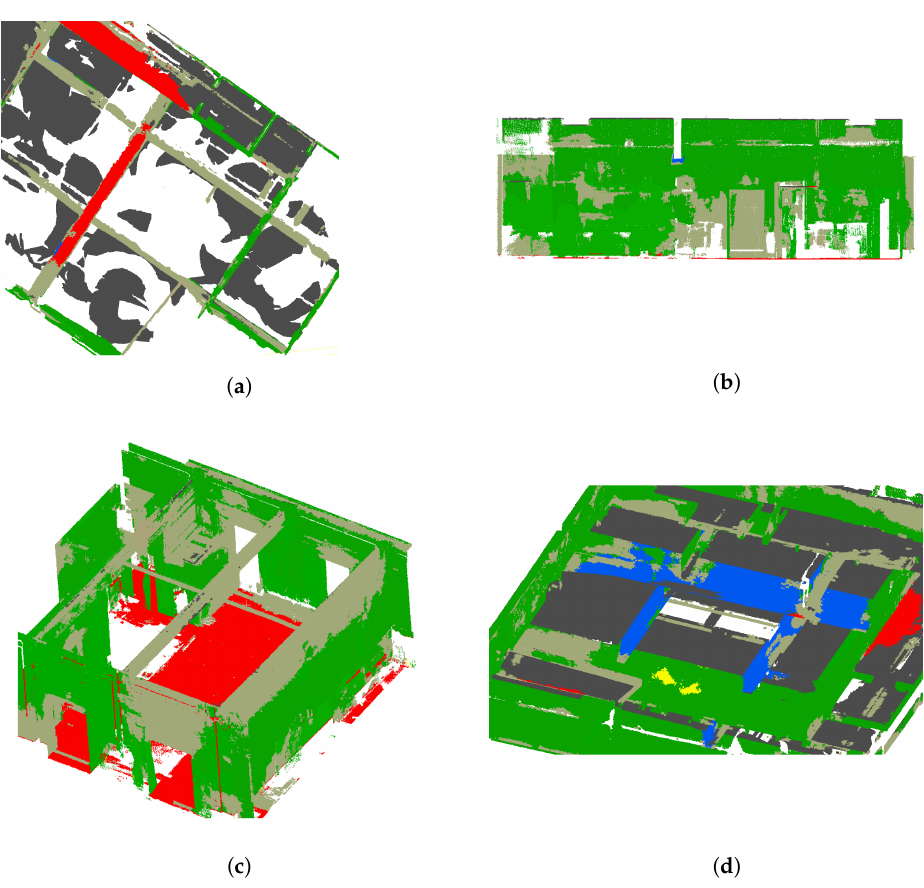
Figure 14. Segmentation shortcomings: Problems in the semantic segmentation that are unrelated to the input data. ( a ) Ceilings are correctly labeled despite large parts of missing data, ( b ) Due to clutter close to the walls some parts are wrongly labeled, ( c ) I-profile beam was not recognised in any of the datasets and ( d ) Rectangular beams are partially found in most